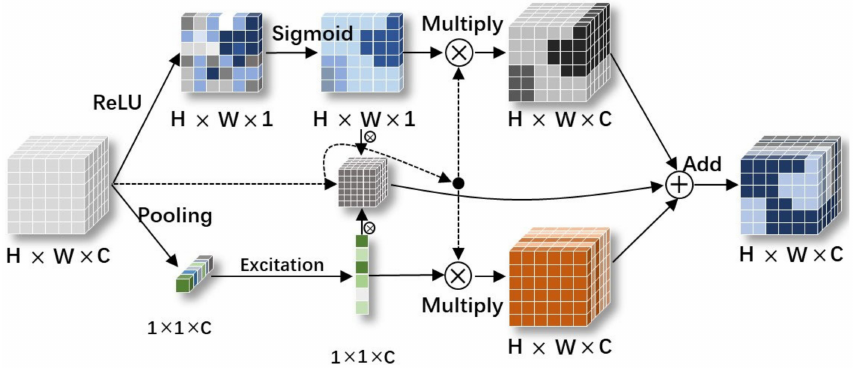
Figure 4. The structure of the deep attention